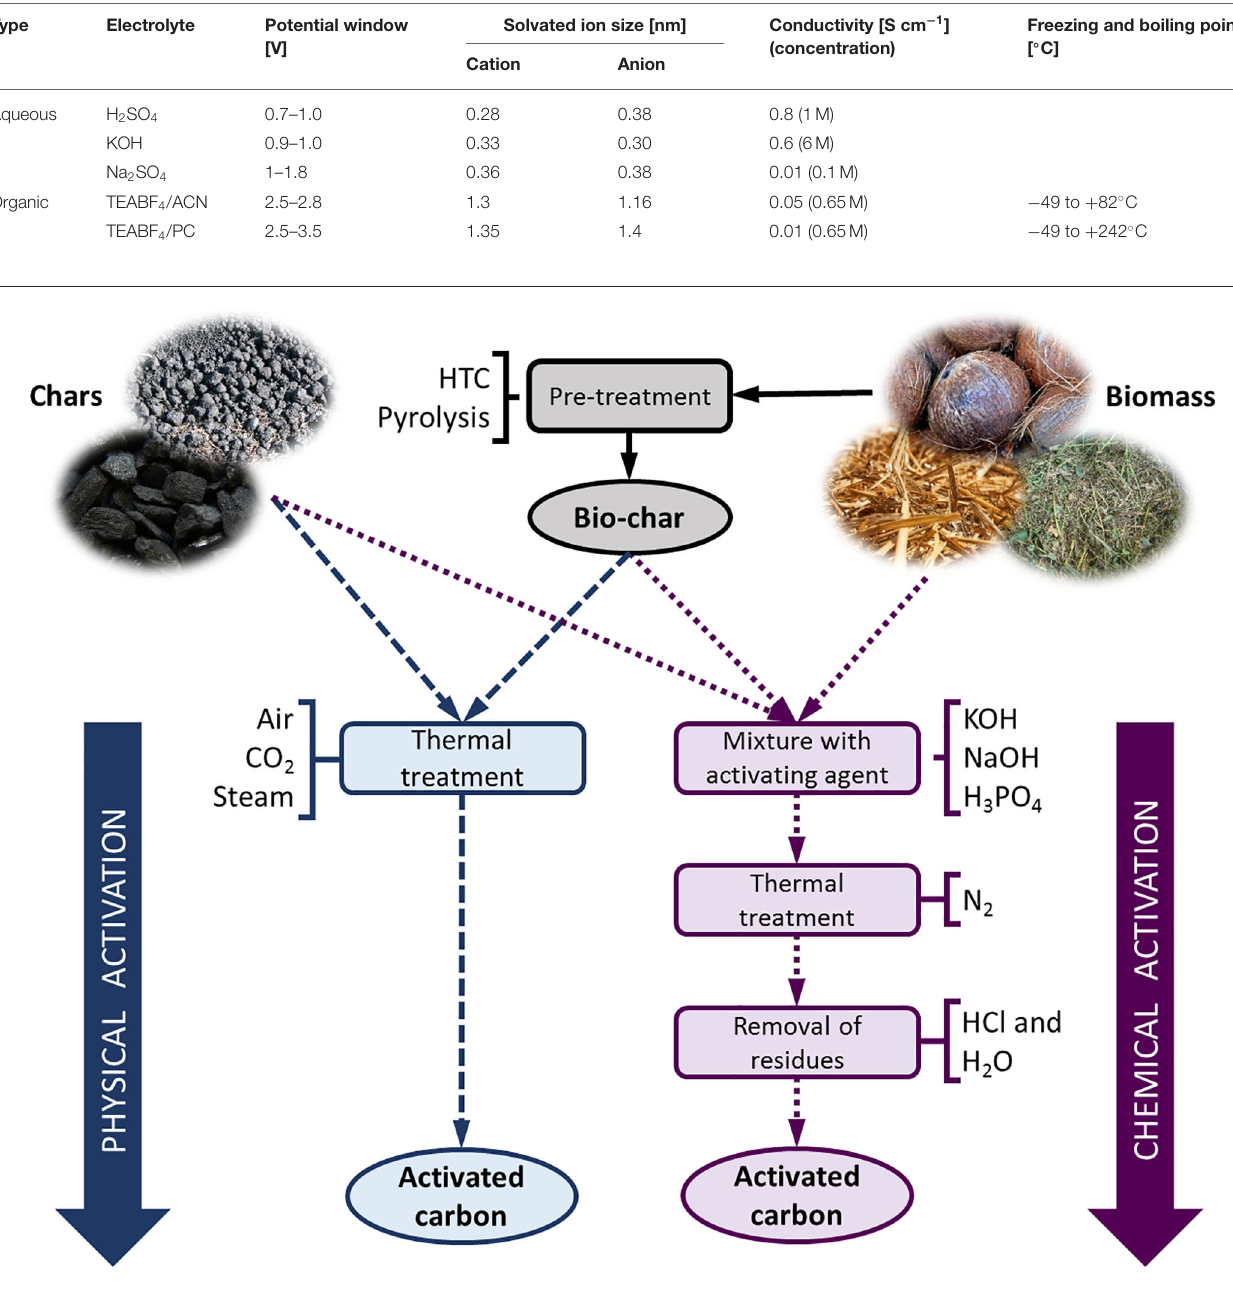
FIGURE 5 | Schematic production process of activated carbons, from biomass and char, by physical or chemical activation.